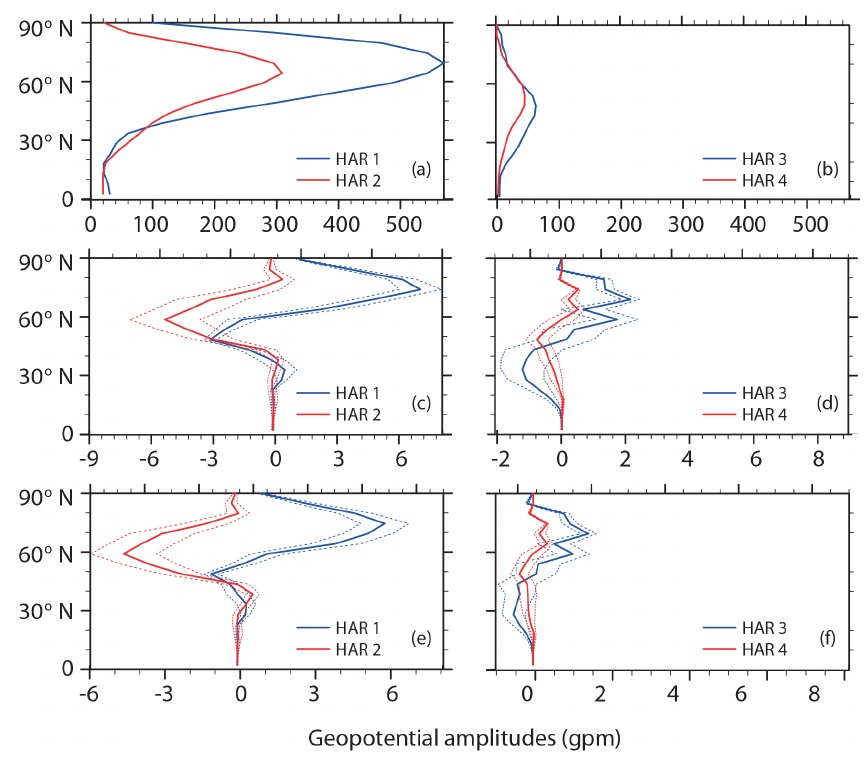
Figure 9. Mean (7th to 30th day) latitudinal structure of the amplitude of selected harmonics for the Box0.1 simulation. From top left to bottom right: (a) harmonics 1 and 2 for Box0.1, (b) harmonics 3 and 4 for Box0.1, (c) differences of (a) from the reference simulation, (d) differences of (b) from reference simulation, (e) differences of (a) from Zon0.1, (f) differences of (b) from Zon0.1. At approx. 35km log-pressure height. Units are given in (gpm). Dotted lines show the standard deviation